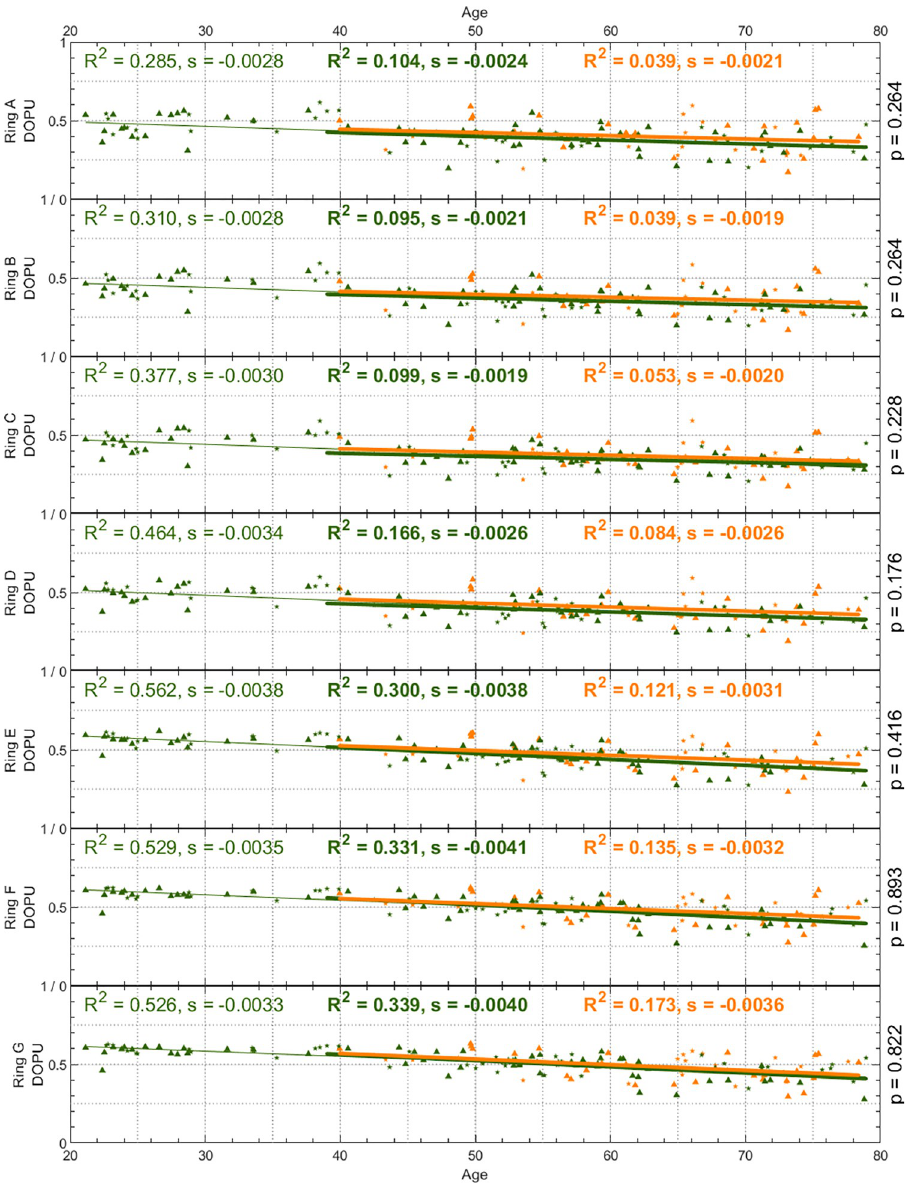
Fig 5. DOPU plotted against the age of the participants for each ring of the evaluation grid in Fig 2. Healthy volunteers are plotted in green (N = 105), glaucoma patients in orange (N = 48). Female participants are represented with a triangle, male participants with a star. For the healthy volunteers aged 39 years or older (bold) and glaucoma patients (bold) as well as for the healthy volunteers of all ages (normal), linear regression lines were plotted and the coefficients of determination (R 2 ) and slopes (s) were calculated. On the right-hand side of each plot, the p-value of Student’s unpaired t-test between healthy volunteers and glaucoma patients is